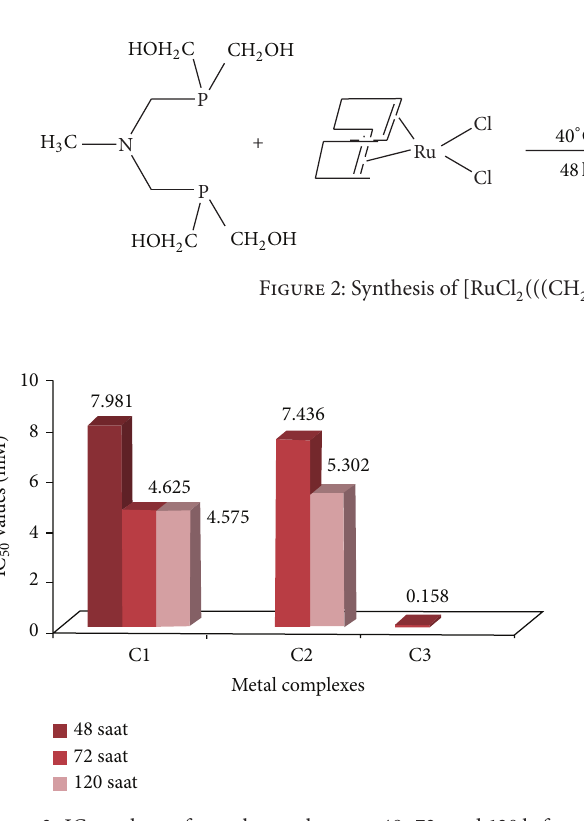
Figure 3: IC 50 values of metal complexes at 48, 72, and 120h for A549 cells.